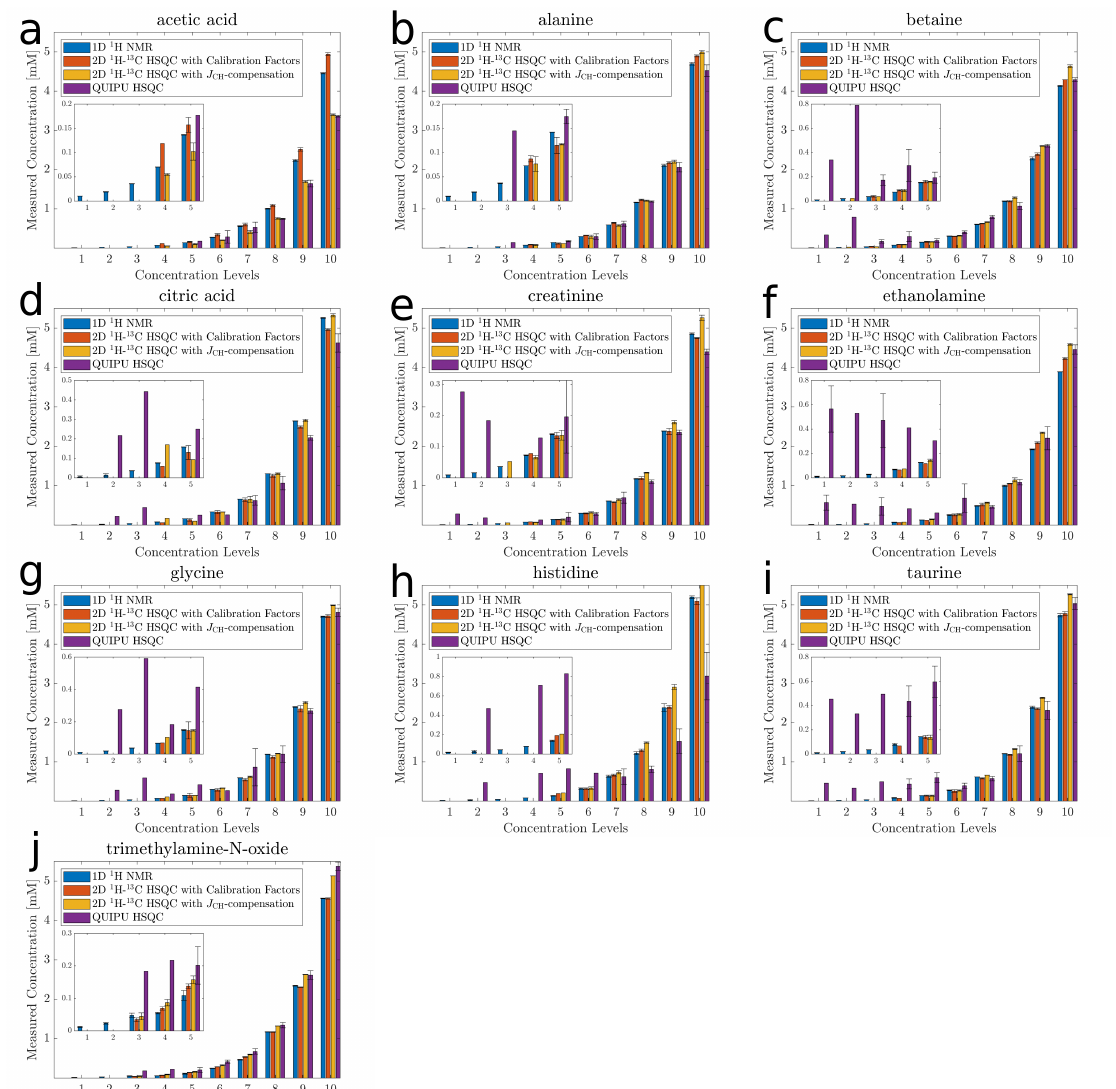
Figure 2. Comparison of concentration estimates for acetic acid ( a ), alanine ( b ), betaine ( c ), citric acid ( d ), creatinine ( e ), ethanolamine ( f ), glycine ( g ), histidine ( h ), taurine ( i ), and trimethylamine-N-oxide ( j ). The x -axis shows the ten concentration levels and the y -axis the observed concentrations with 1D 1 H NMR in blue, standard HSQC in red, Q-HSQC in orange and QUIPU-HSQC in purple. The lower five concentration levels are added as inserts. The concentration values are means over technical triplicates. In the case that the compound was detected in all three replicates, the corresponding standard deviation is included as a measure of